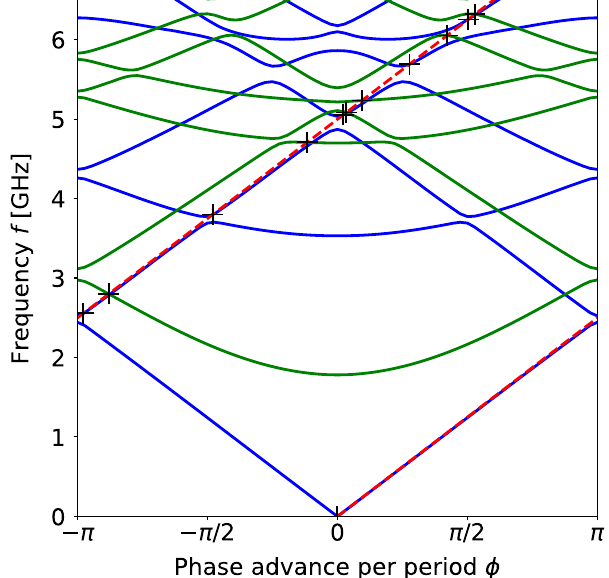
FIG. 6. Dispersion diagram for the circular pipe structure depicted in Fig. 5. The blue lines correspond to longitudinal modes, and the green lines correspond to transverse modes ( X direction). The synchronous points are marked with black crosses.